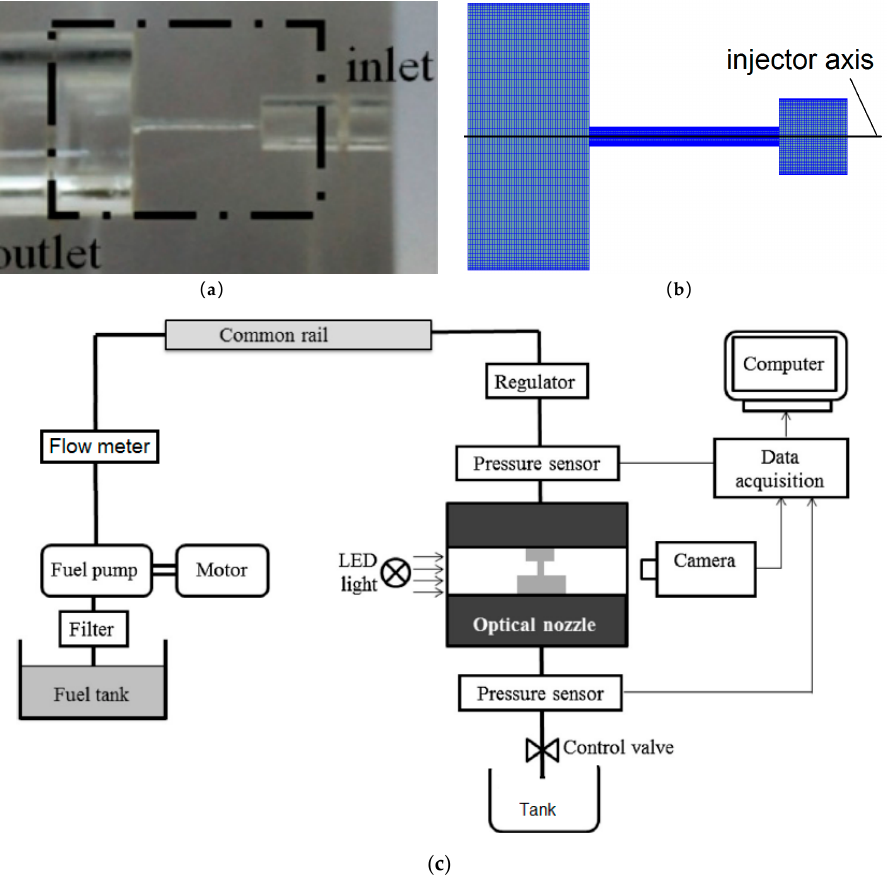
Figure 3. Practical nozzle and experimental bench. ( a ) Experimental model, ( b ) Mesh model, ( c ) Test rig.